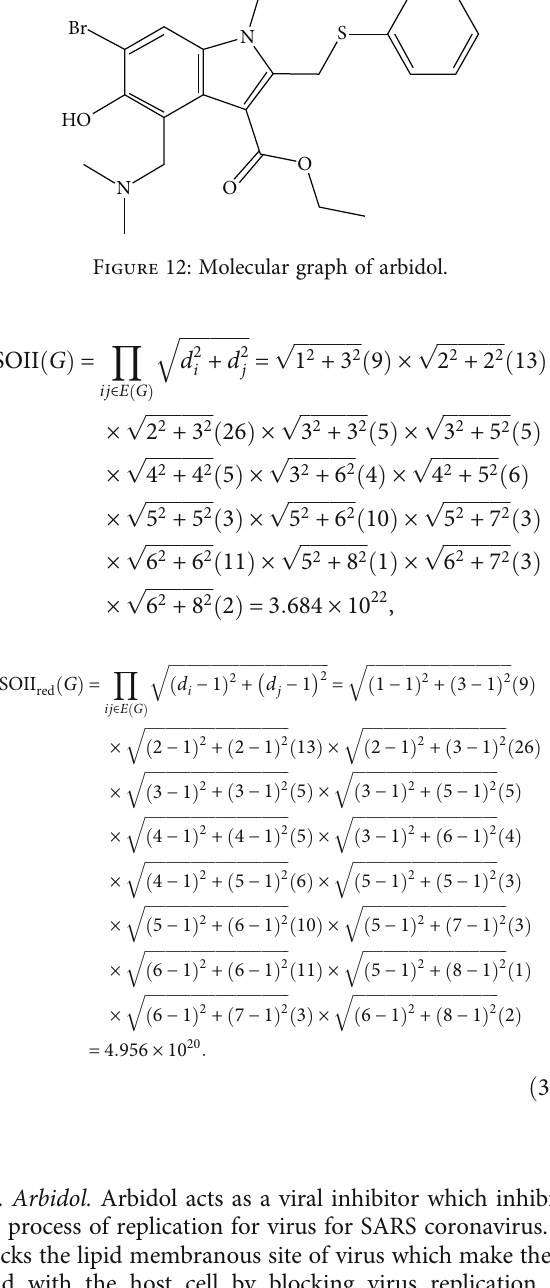
Table 6: Edge partitioning based on degree of